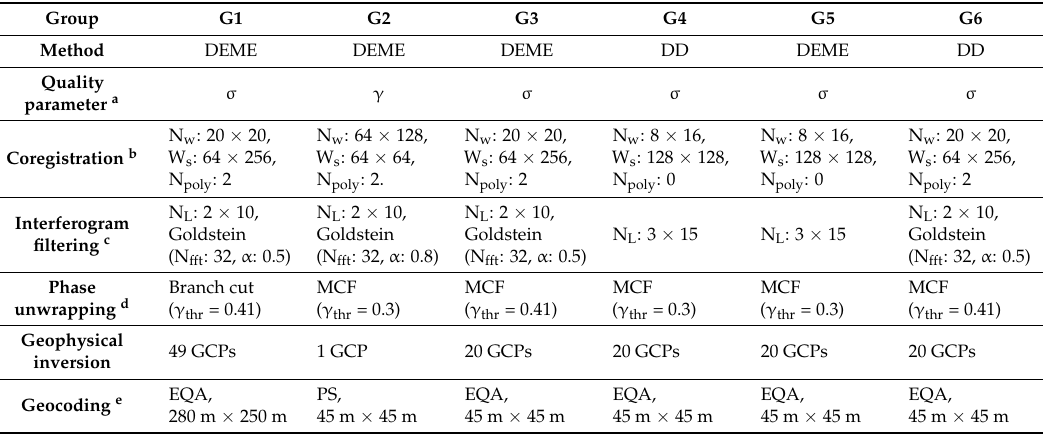
Table 3. Task 1 main processing